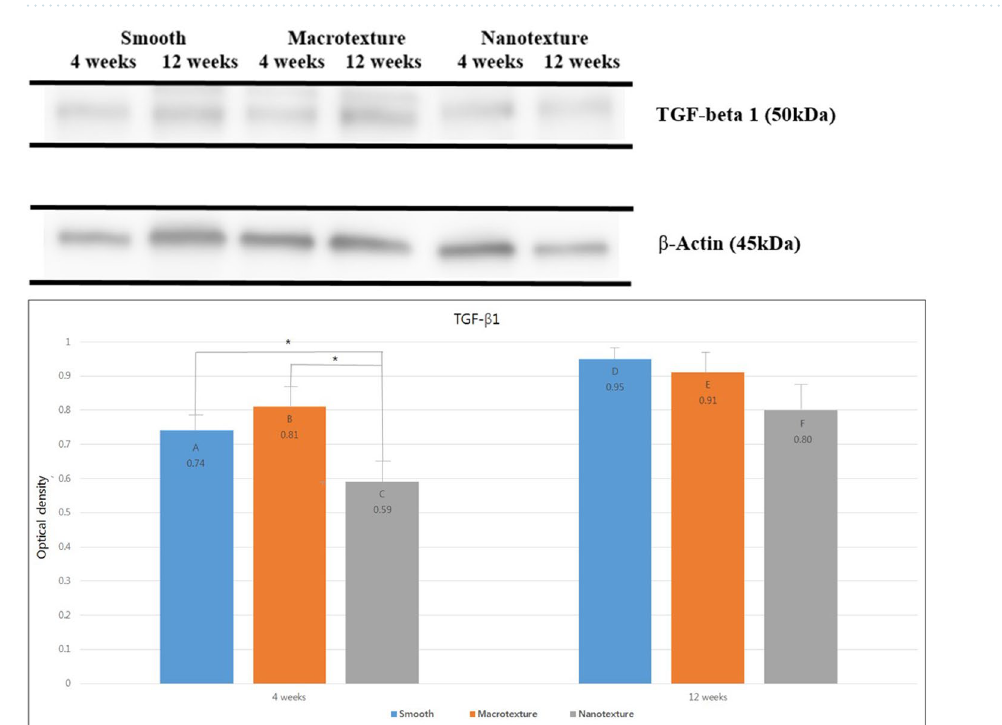
Figure 5. Western blot analysis of TGF-β1 in the three different types of silicone implants. Expression of TGF- β1 and β-Actin were analyzed using Western blotting. Bar graph showing the optical density of TGF-β1. Black asterisks in the bars represent P values indicating significant differences between the groups ( P < 0.05). Group A (4 weeks, smooth type), Group B (4 weeks, macrotexture type), Group C (4 weeks, nanotexture type), Group D (12 weeks, smooth type), Group E (12 weeks, macrotexture type), Group F (12 weeks, nanotexture type). Additional information is mentioned in supplementary